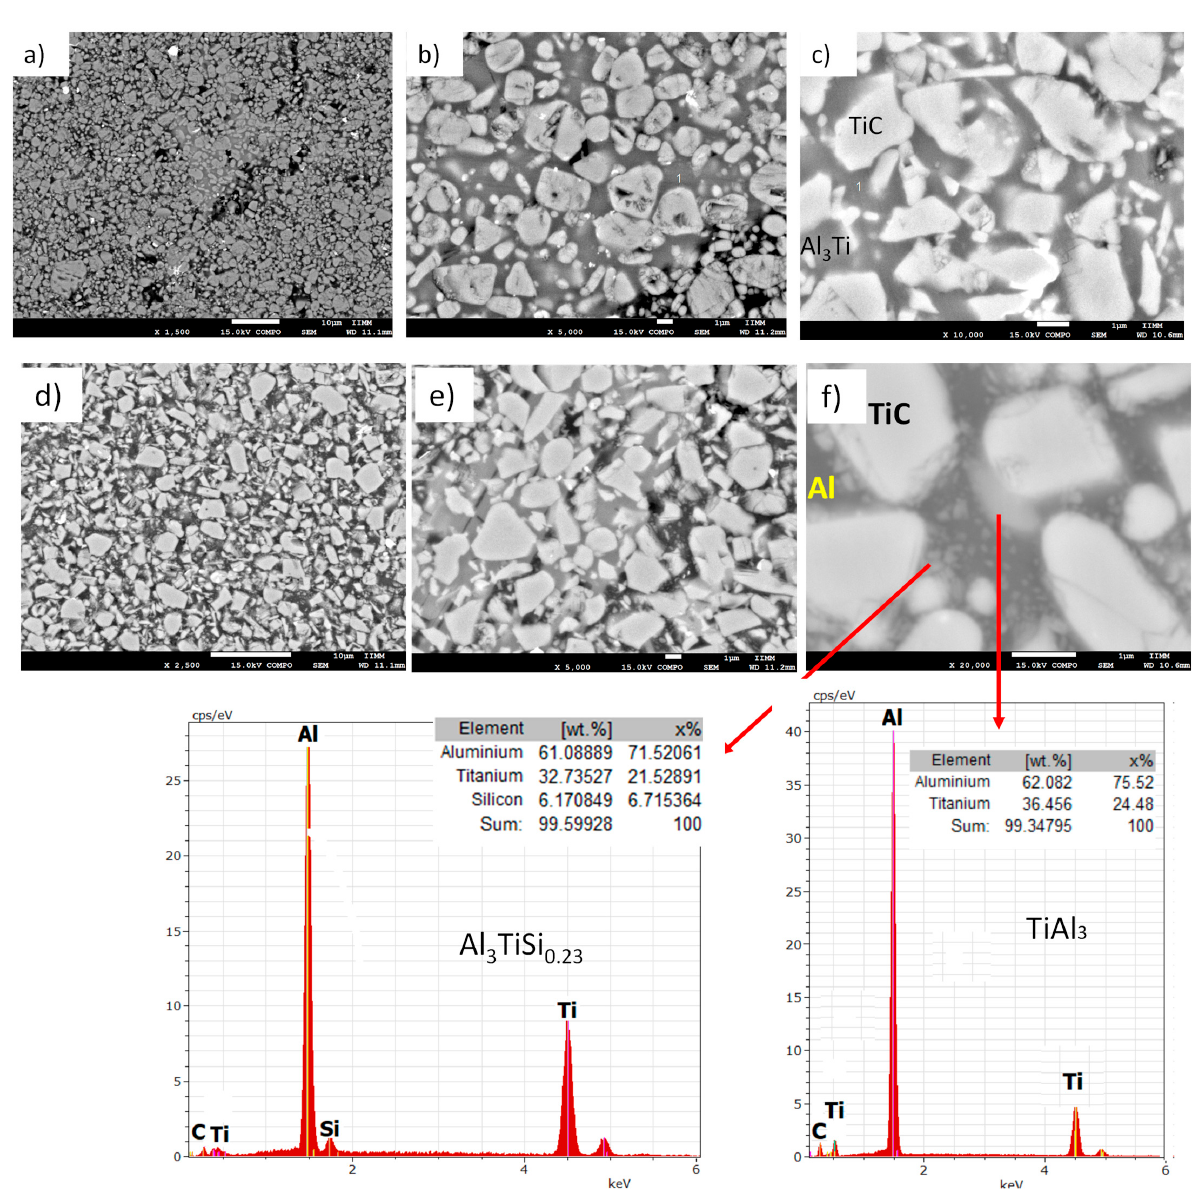
Figure 3. SEM micrographs of composites ( a – c ) as-infiltrated and ( d – f ) after heat treatment. EDX spectra and chemical composition of the precipitated phase observed in Figure 3f.